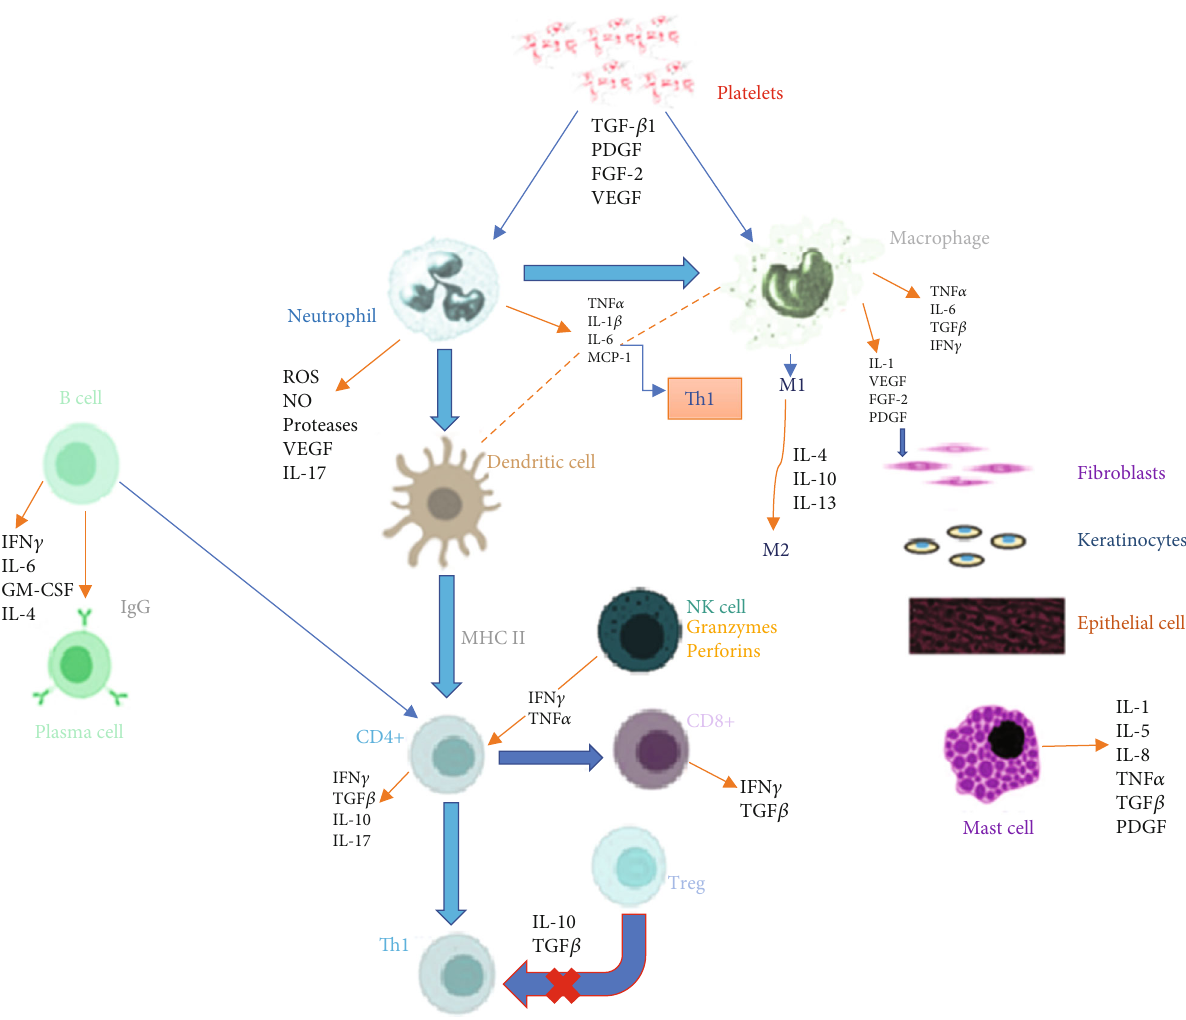
Figure 1: Summary of pro- and anti-in fl ammatory cells and mediators involved in acute wound healing. During haemostasis, platelets are the fi rst to arrive in the wound microenvironment and secrete TGF- β 1, PDGF, FGF-2, and VEGF. These cytokines activate and recruit neutrophils and macrophages [25, 43]. During the in fl ammatory phase, neutrophils secrete ROS, NO, proteases, VEGF, and IL-17 that eliminate pathogens and microbes and promote neutrophil apoptosis [43, 44]. Neutrophils also secrete TNF α , IL-1 β , and IL-6 and MCP-1 that attract monocytes, dendritic cells, and activate T cells causing a Th1 proin fl ammatory response [33, 45]. After neutrophil apoptosis, macrophages undergo e ff erocytosis [46]. M1 macrophages secrete IL-1, VEGF, FGF-2, and PDGF that promote the proliferation of fi broblasts, keratinocytes, and epithelial cells. In early wound healing, macrophages secrete TNF α , IL-6, and TGF β [45]. Macrophages and NK cells secrete IFN- γ that attract T cells to the wound site and increase their proliferation [33, 43]. NK cells appear early in wounds and secrete IFN- γ and TNF α that increase the proliferation of CD4+ T cells. NK cells also release perforins and granzymes that are cytotoxic to infected cells [47]. Mast cells secrete in fl ammatory cytokines such as IL-1, IL-5, IL-8, TNF α , TGF β , and PDGF and granules [14, 48]. During the proliferative and remodelling phases, IL-4, IL-10, and IL-13 induce the transition of M1 to M2 macrophages [43, 47]. Dendritic cells act as APCs to CD4+ T cells via MHC II and costimulatory molecules [49]. Once activated, CD4+ and CD8+ T cells migrate to the wound site and secrete IFN- γ , TGF β , IL-10, IL-17, IL-22, and TGF β [33, 50, 51]. B cells accumulate at the wound site and di ff erentiate into plasma cells that release IgG antibodies that aggravate in fl ammation. B cells act as APCs encouraging T cell activation and secrete IL-6, IFN γ , GM-CSF, and IL-4 [52]. Tregs maintain homeostasis and secrete anti-in fl ammatory cytokines like IL-10 and TGF β that inhibit Th1 cells activity (indicated with an X) [53]. Key: TGF- β : transforming growth factor-beta; PDGF: platelet-derived growth factor; FGF: fi broblast growth factor; VEGF: vascular endothelial growth factor; ROS: reactive oxygen species; NO: nitric oxide;